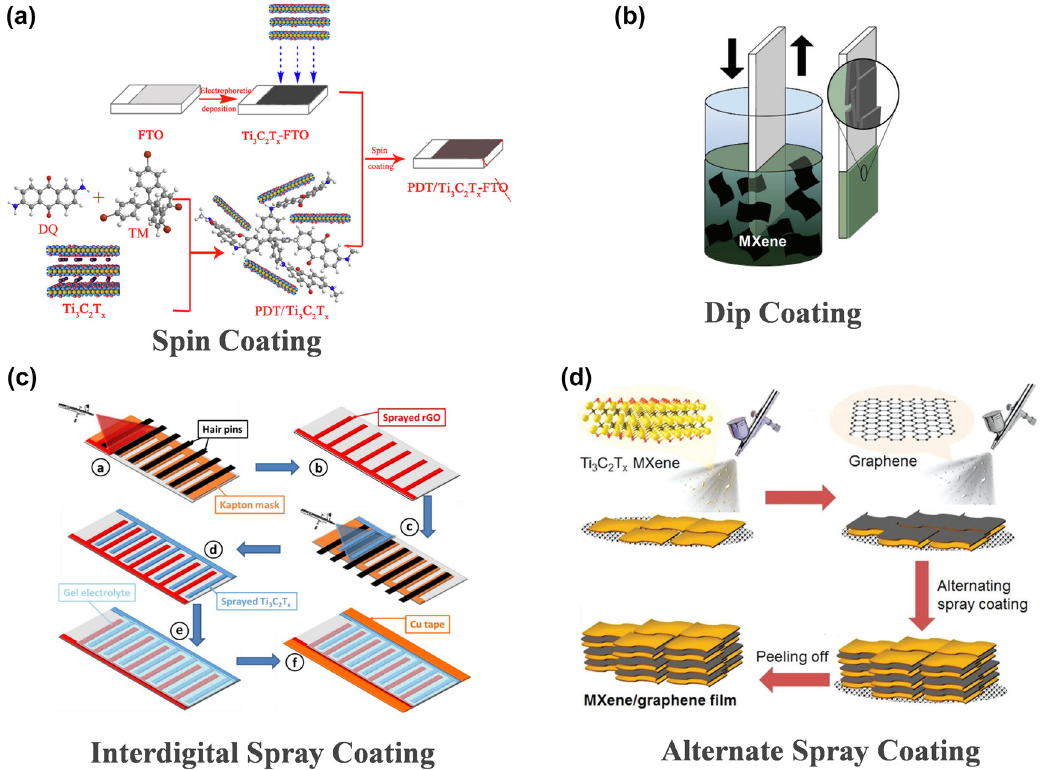
Figure 1: The methods of coating. (a) Schematic illustration for the fabrication of PDT/Ti Schematic image of optically transparent Ti